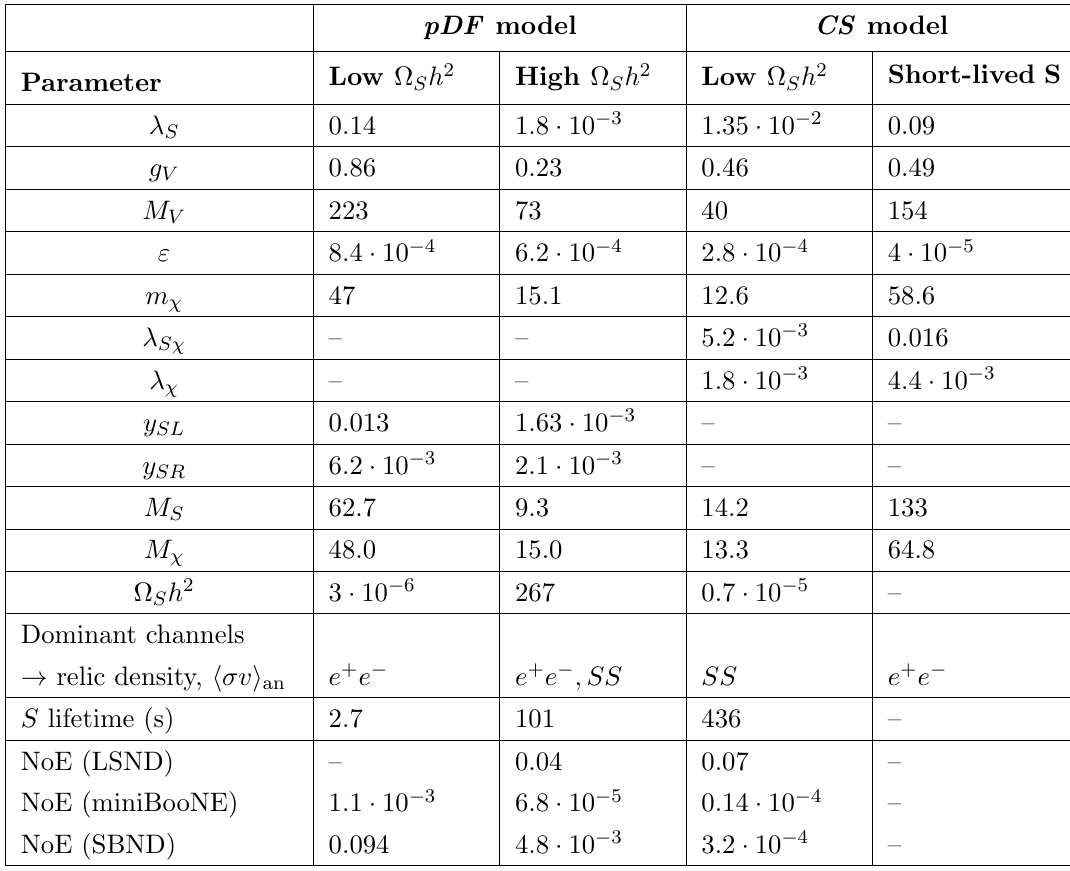
Table 4. Benchmark points for the models analyzed in this work. Mass-related quantities are given in MeV and MeV 2 , cross-section times velocity are in cm 3